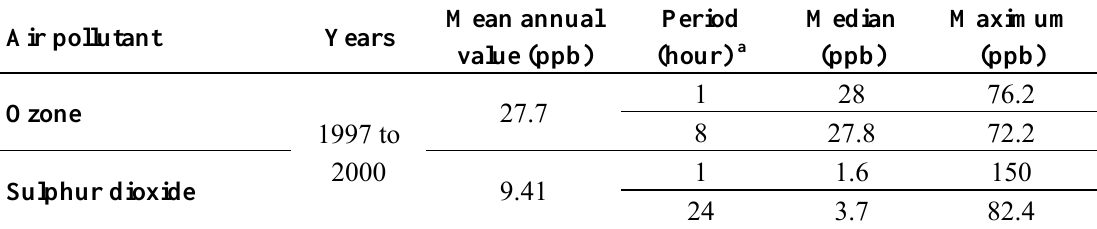
Table 2. Levels of air pollutants measured in four places in the SLSJ